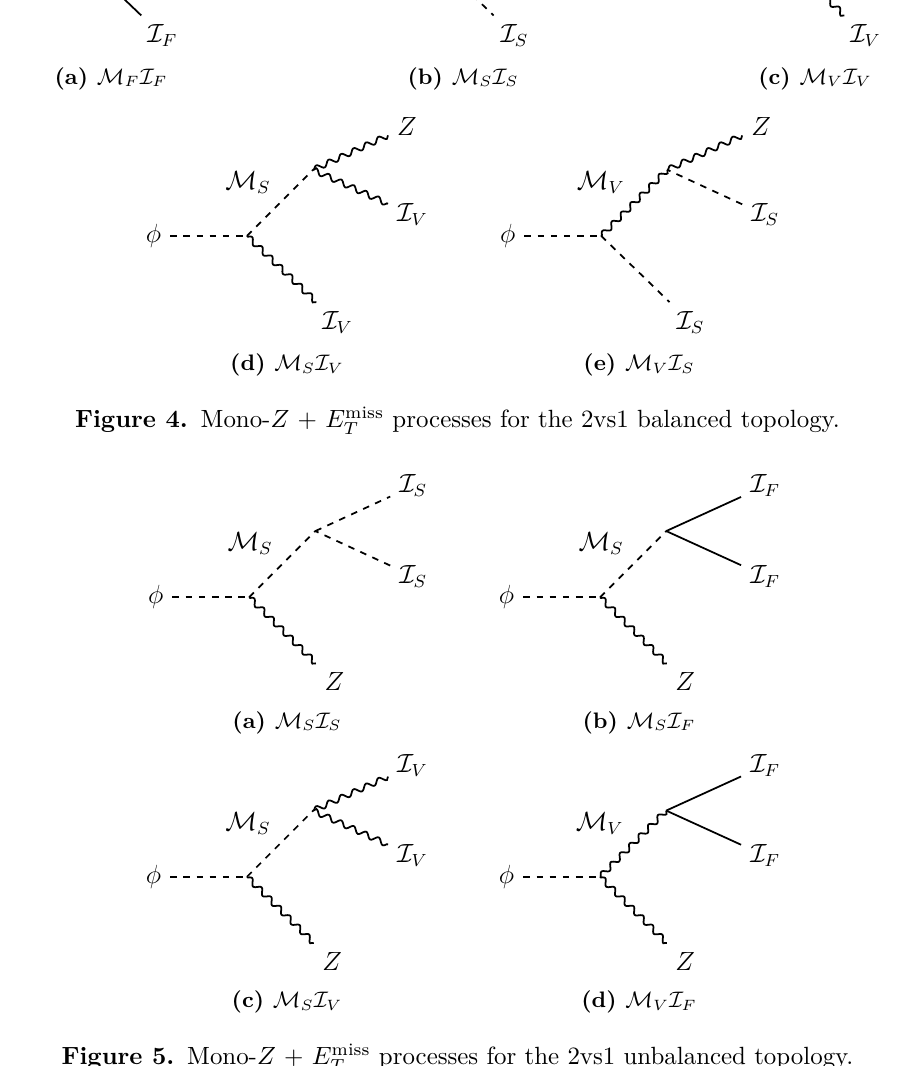
processes for the 2vs1 unbalanced T